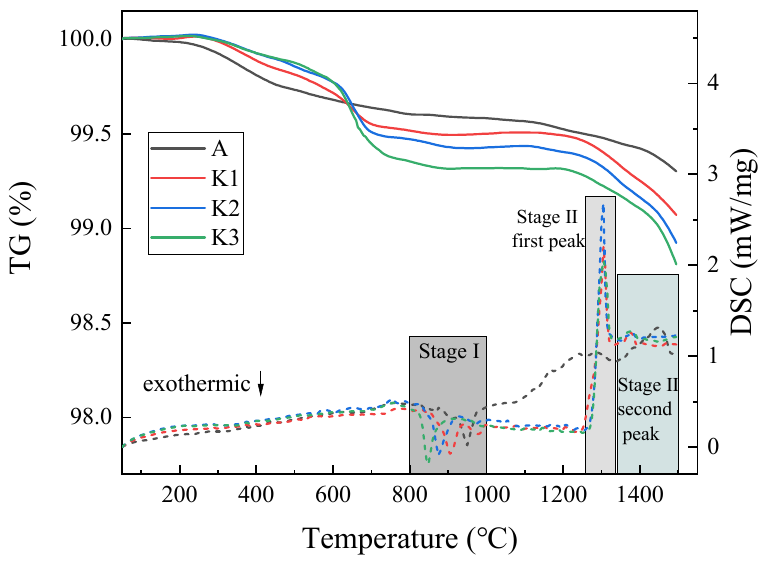
Figure 4. The TG (solid line) and DSC (dotted line) curves of the slag at different K 2 O contents.